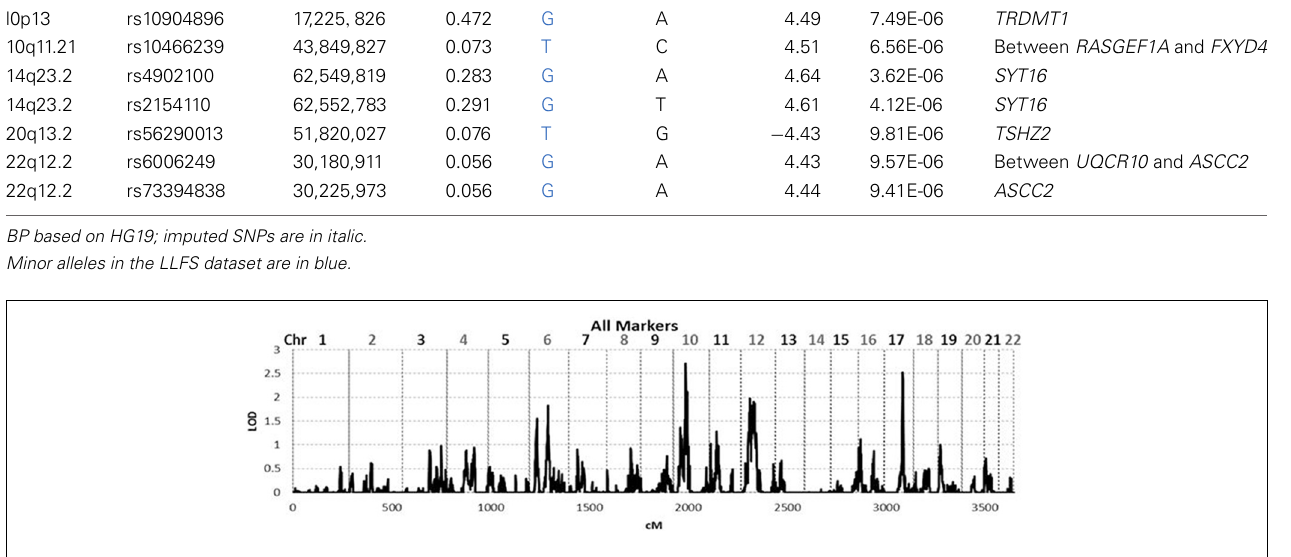
FIGURE 2 | Genome wide linkage analysis using SOLAR. Genome wide linkage analysis based on haplotype IBD, adjusting for age, sex, education, site, smoking, alcohol consumption, marital status, a history of heart disease, and 1 principle component.